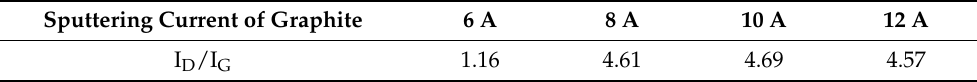
Figure 5. ( a ) Raman spectra and ( b ) XRD pattern of TiC/GLC multilayered films at various sputtering currents of graphite. Table 2. I D /I G ratio as function of sputtering currents of graphite for TiC/GLC films.